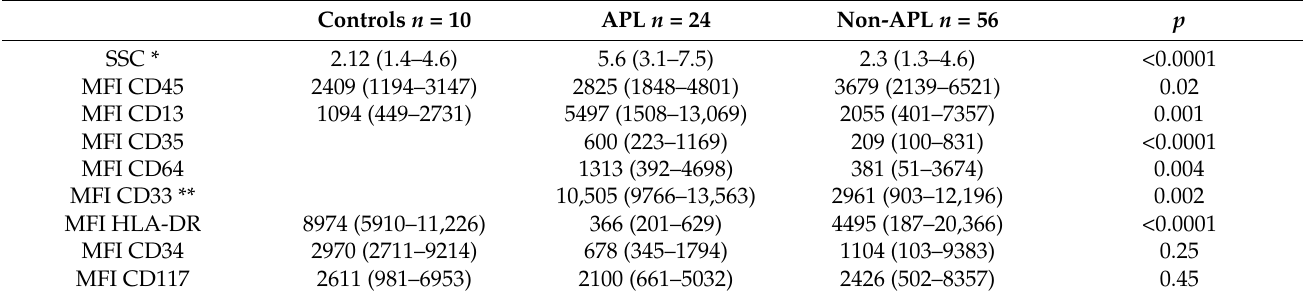
Table 2. Side scatter (SSC) and mean fluorescence intensity (MFI) of the antigens tested. Median (percentiles 10–90%). Comparison by the Kruskal–Wallis